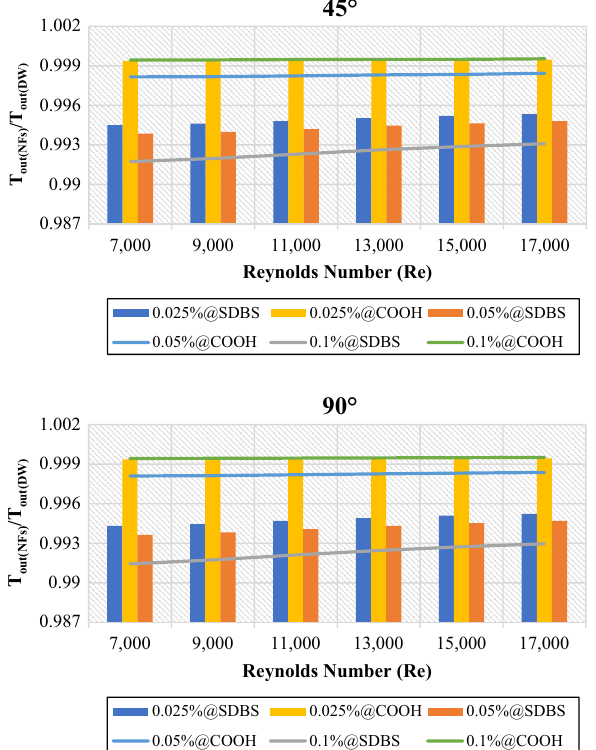
Figure 4. Outlet temperature of nanofluids to base fluid versus Reynolds numbers for 45° and 90° tubes.